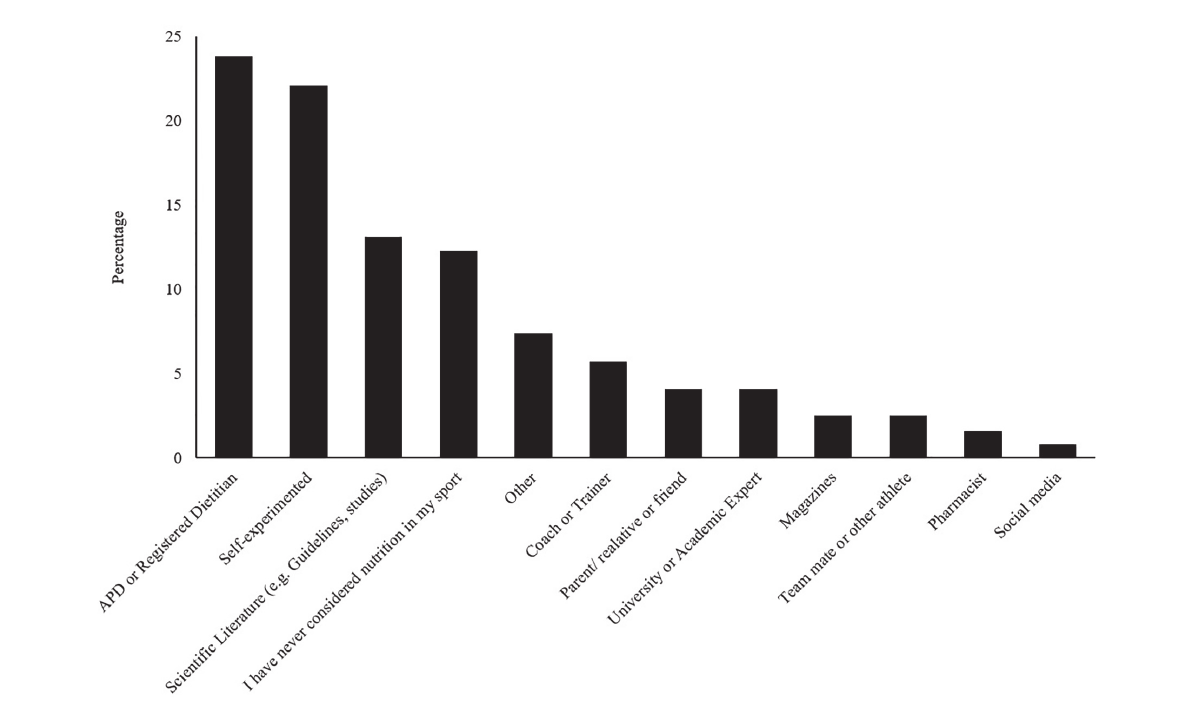
FIGURE3 Endurance athletes’ most important information sources for managing exercise-associated gastrointestinal symptoms around exercise ( n = 122 respondents). APD, Accredited Practicing Dietitian.